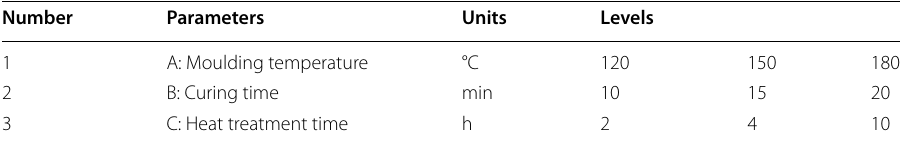
Table 1 Experiment settings showing the factors and levels Number